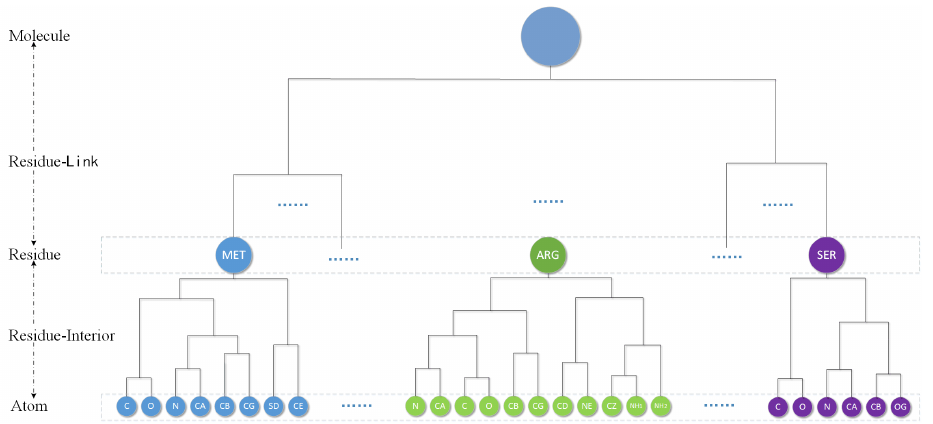
Figure 7. The whole cluster tree of a protein molecule from